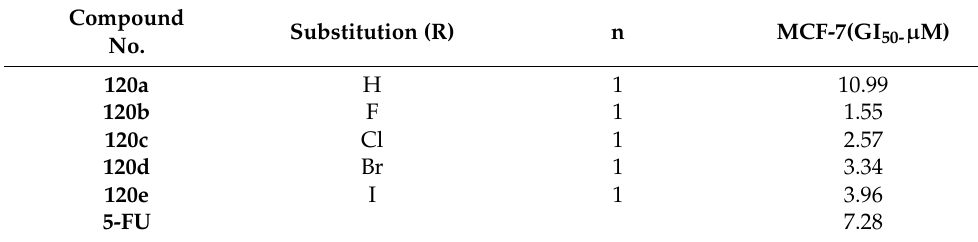
Figure 115. Structure of coumarin ‐ based furoxin derivatives 121 ( a – e ). Table 102. In vitro cytotoxic activities of coumarin ‐ based furoxin hybrid compounds 121 ( a – e ). Compound No.